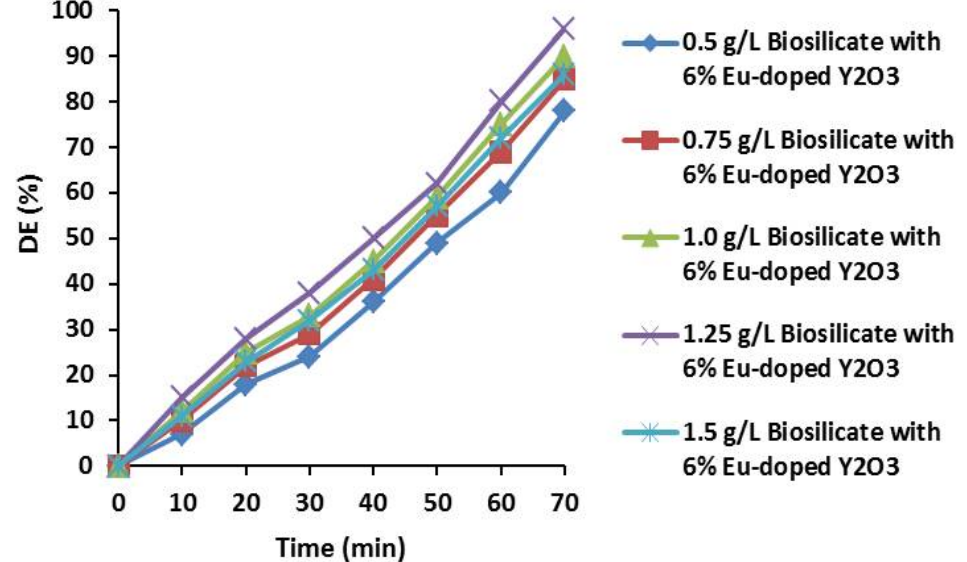
Figure 16. Influence of diatomite coated 6% Eu-doped Y 2 O 3 concentration on the decolorization of RB19, [Dye] = 20 mg/L, pH = 6.